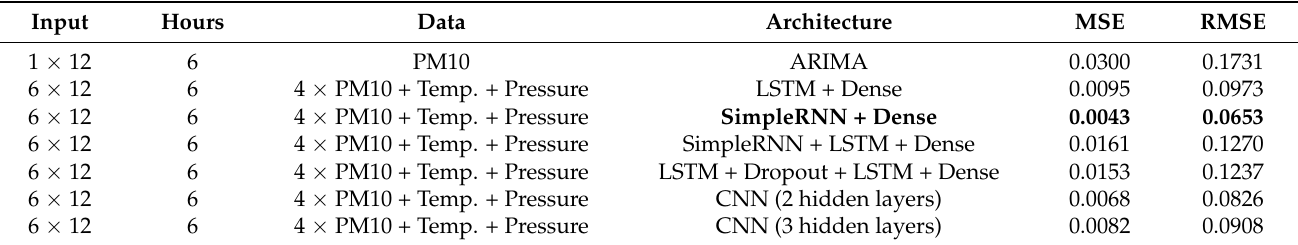
Table 4. Summary of the evaluated approaches with the achieved average forecasting performance in terms of Mean Squared Error (MSE) and Root Mean Squared Error (RMSE) for the 6 h time horizon. The best performance for is marked in